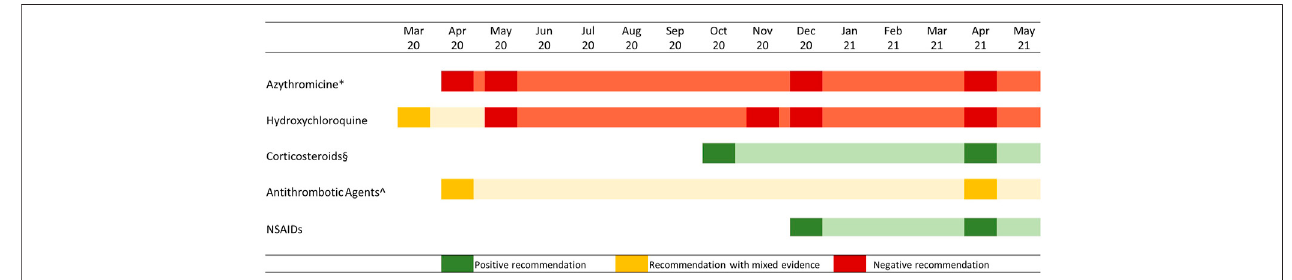
FIGURE 1 | AIFA recommendations on the use of speci fi c drug categories in the outpatient treatment of COVID 19 cases. Note: Attenuated colors show information on card validity, in case of update the diagram reported a new rectangle. * From December 2020 onward, the negative recommendation regarded all antibiotic agents; § Corticosteroid use was recommended in subjects with severe COVID-19 disease mostly combined with oxygen therapy; ^ Antithrombotic use was recommended in hospitalized patients, while outpatient use was